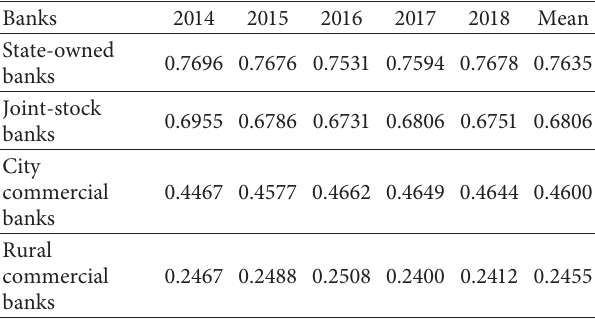
Table 11: Average inefficiency dominance probabilities for four kinds of listed